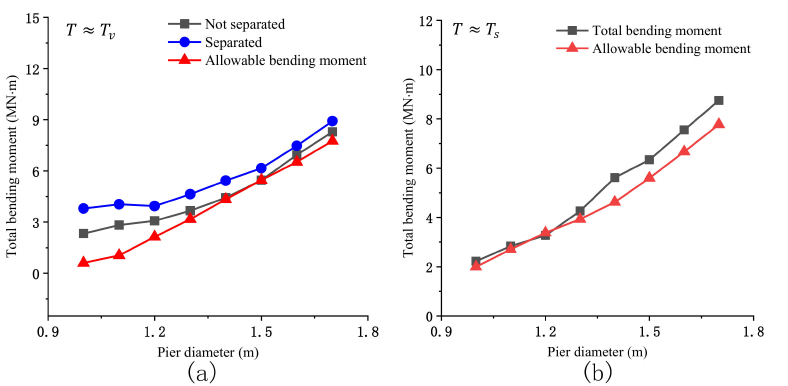
Figure 14. Failure at the base of the pier with different diameters: ( a ) Total bending moment and allowable bending moment at the base of the pier when T ≈ T s ; ( b ) total bending moment and allowable bending moment at the base of the pier when T ≈ T v